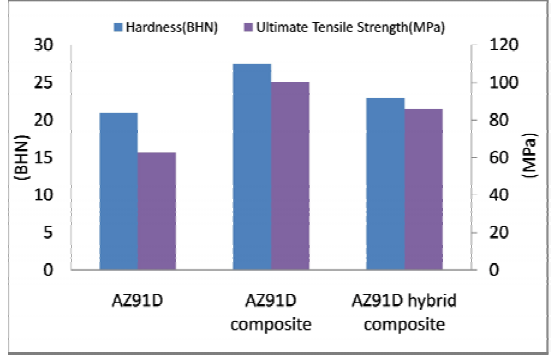
Fig. 3. Variation of hardness and ultimate tensile strength of AZ91D, AZ91D/B C composite and 4 AZ91D/ B C/Gr hybrid composite, adapted from 4